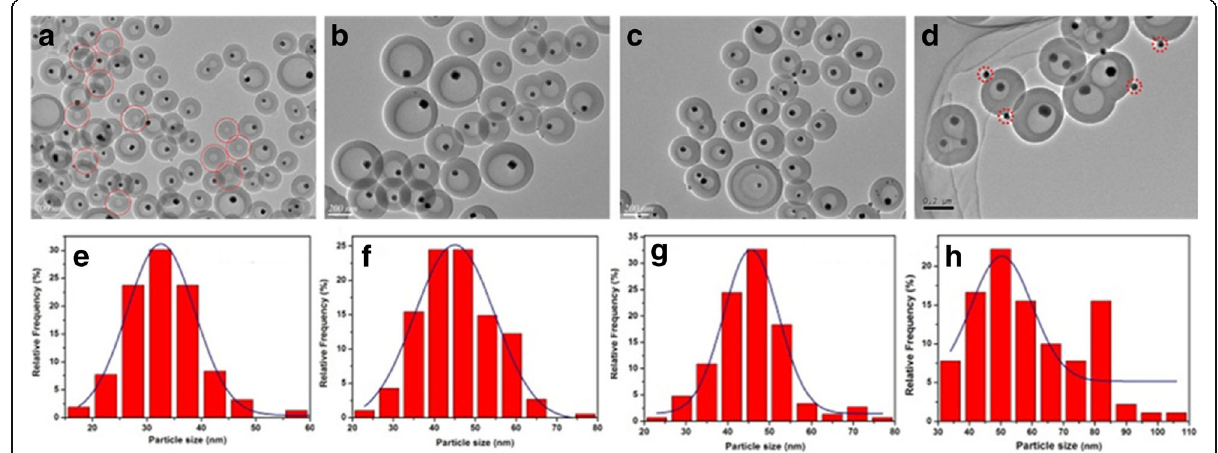
Fig. 4 TEM images and corresponding size distribution histograms of Cu NPs in samples: a , e Cu@C-0.03, b , f Cu@C-0.06, c , g Cu@C-0.12, and d , h Cu@C-0.24